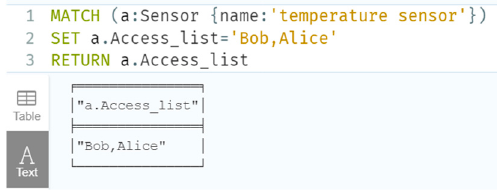
Figure 16. The set device access permissions.